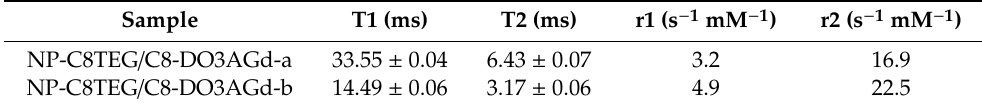
Table 1. T1 and T2 relaxation times determined on 40 mg / mL aqueous solutions of nanoparticles